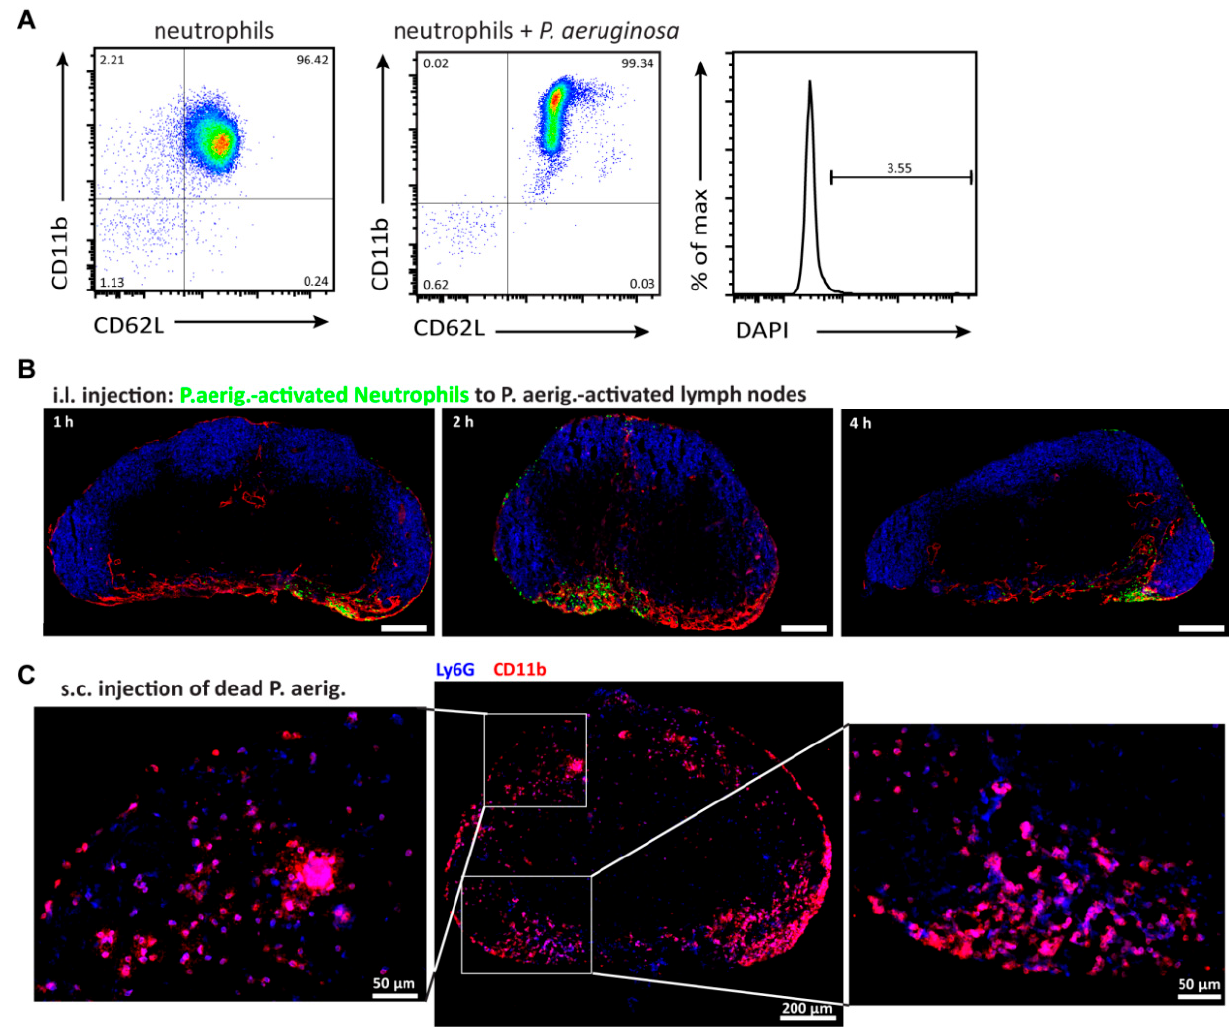
Figure 3. Neutrophil positioning in P. aeruginosa –activated popliteal lymph nodes. ( A ) FACS plots showing the activation status of resting neutrophils ( left ) or neutrophils incubated with heat-inactivated P. aeruginosa for 60 min ( middle ). The right histogram depicts DAPI–positive cells after activation in vitro. Representative plots from 5 independent experiments are shown. ( B ) Popliteal lymph node 1-day post-immunization with heat-inactivated P. aeruginosa and 1, 2 or 4 h after i.l. transfer of P. aeruginosa -activated neutrophils (green). Lymph node cryosections were stained with the following antibodies anti-LYVE-1 (red) and anti-IgD (blue). Scale bar; 200 µ m; a total of 12 lymph nodes was analyzed for all time points investigated. ( C ) An overview of a cryosection from a P. aeruginosa –activated popliteal lymph node 1-day post-immunization stained with anti-Ly6G (blue) and anti-CD11b (red) is shown. Twenty × zoom-in pictures are shown for the subcapsular sinus region (left picture) as well as the medullary region (right picture) of the lymph node. Double positive cells (Ly6G + CD11b + in pink) depict infiltrated endogenous neutrophils. Scale bar overview 200 µ m; zoom in, 50 µ m. Representative data of 3 lymph nodes are